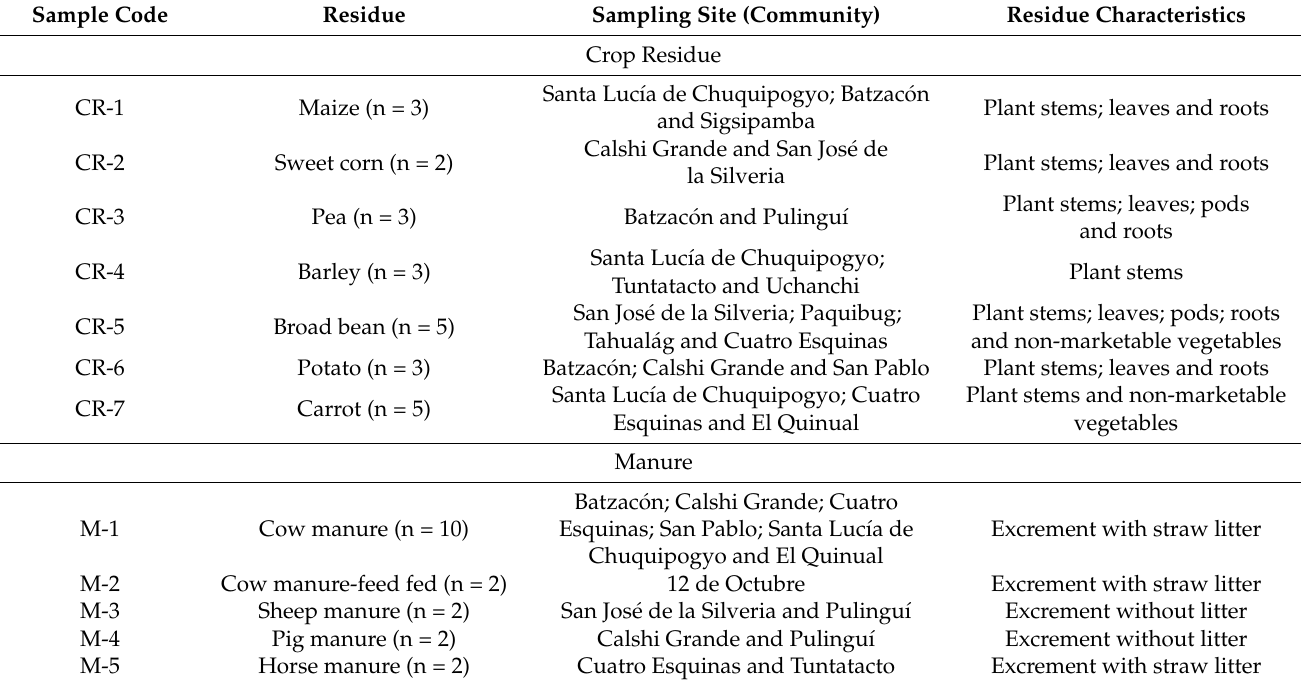
Table 1. Origin and general characteristics of the agro-livestock